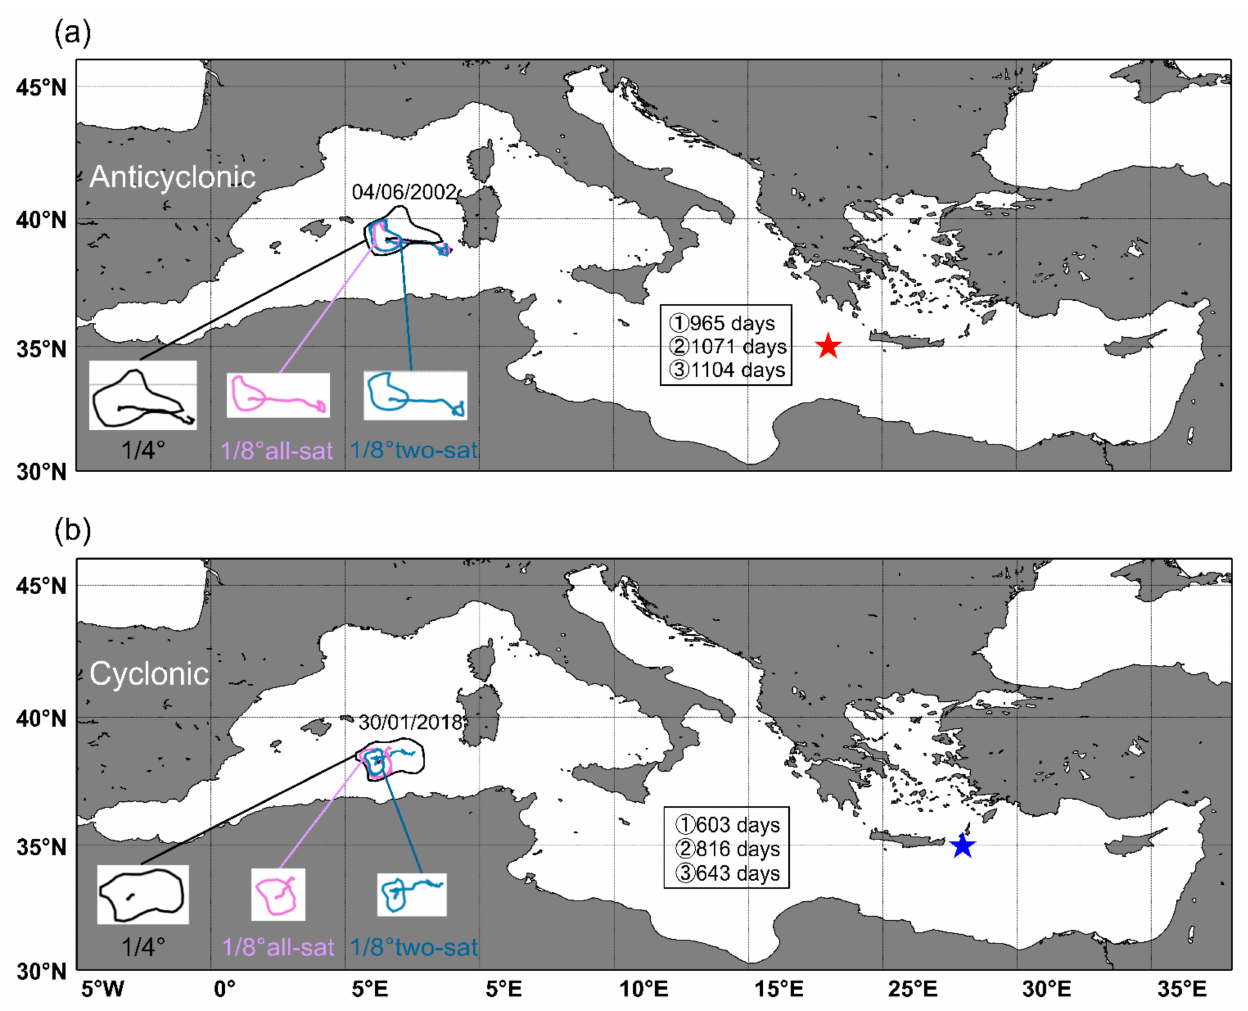
Figure 6. Results from tracking typical eddies in the Mediterranean Sea. ( a ) represents typical anticyclonic eddies and ( b ) represents typical cyclonic ones. The red (blue) stars in the figure represent the location of the anticyclonic (cyclonic) eddy with the longest life in the Mediterranean Sea from 1993 to 2018. The three lifetimes indicated in the insert boxes are the tracking results based on 1/4 ◦ , 1/8 ◦ all-sat, and 1/8 ◦ two-sat datasets respectively. The shapes and trajectories of the long-distance eddies are shown in inserts on the left. The black lines represent the eddy identified using the 1/4 ◦ data, and the magenta (desert blue) lines represent the eddy identified using the 1/8 ◦ all-sat (two-sat)